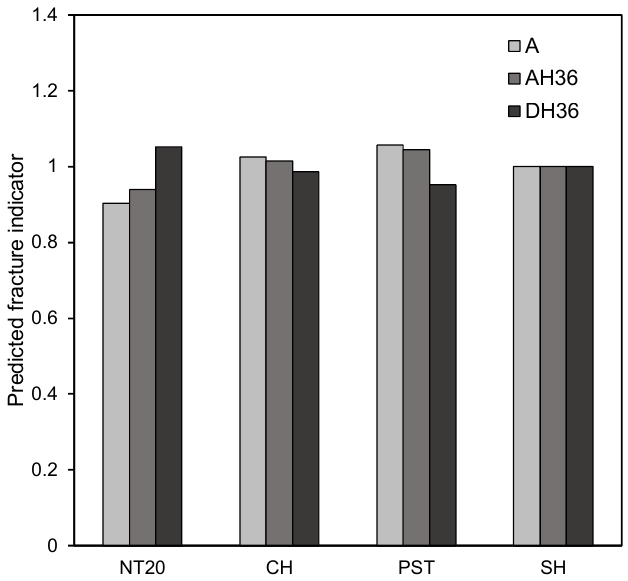
Figure 17. Accuracy of the prediction of fracture initiation using the proposed